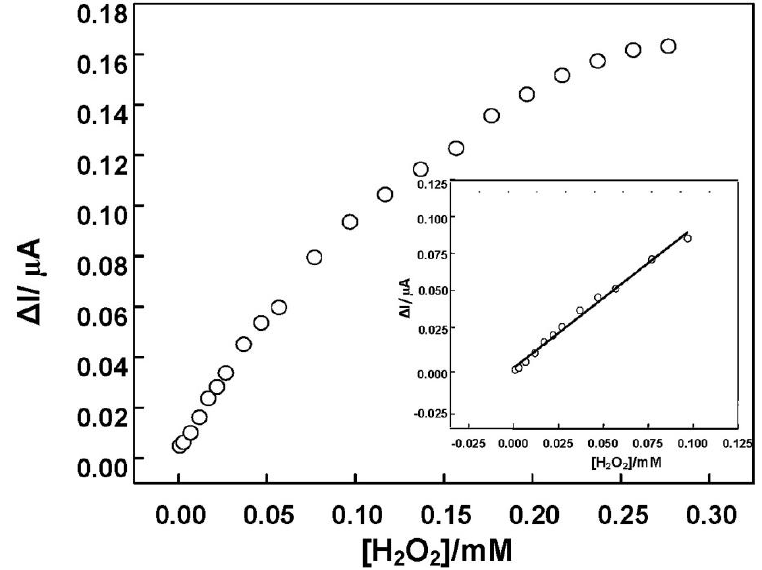
Figure 9. The calibration curve of amperometric response of DNA/chitosan/Fe to H O concentration at the constant electrode potential of −0.25 V. Measurement conditions 2 2 were the same as in Figure